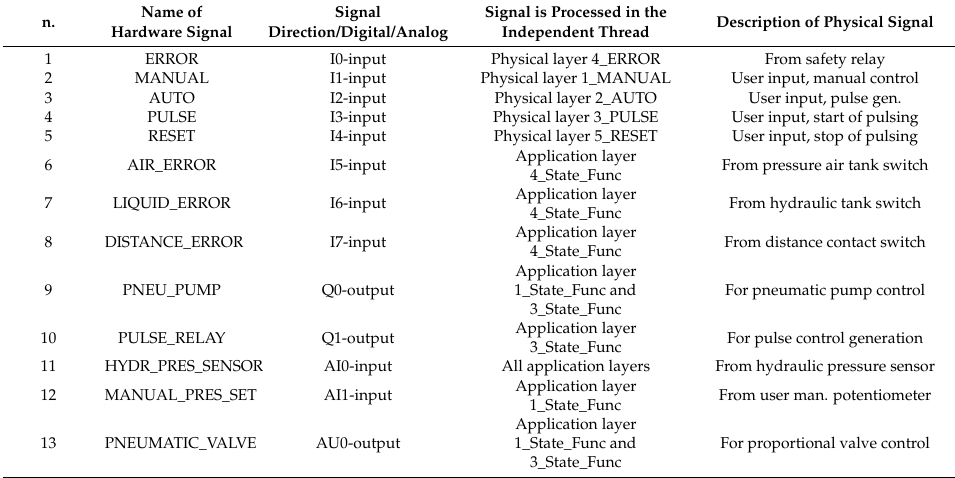
Table 1. List of programmable logic controller (PLC) hardware inputs and outputs and their responsible processing layer.